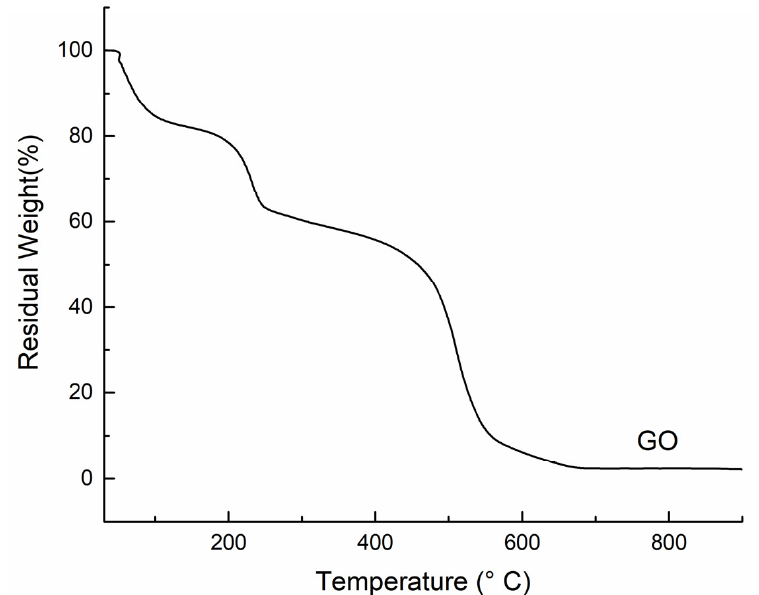
Figure 2. TG curve recorded under O 2 flow for the synthesized GO.